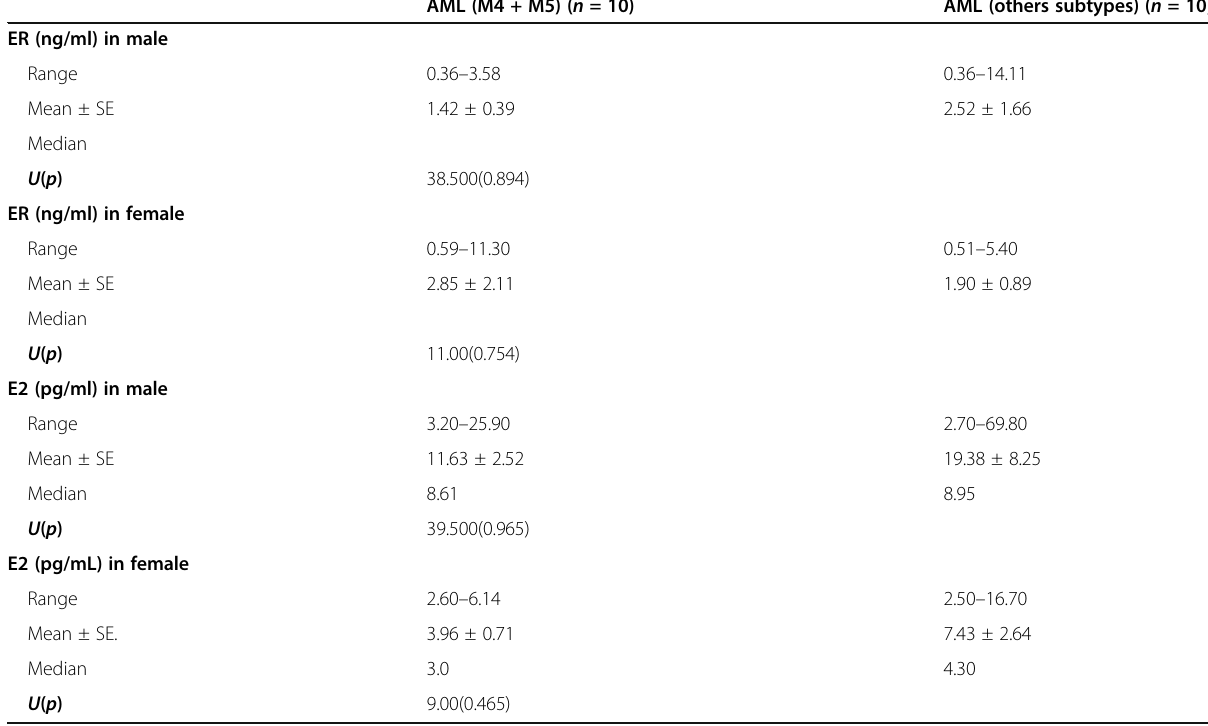
Table 2 Serum ER level (ng/ml) and E2 level (pg/ml) in AML (M4+M5) and AML (other subtypes) male/female